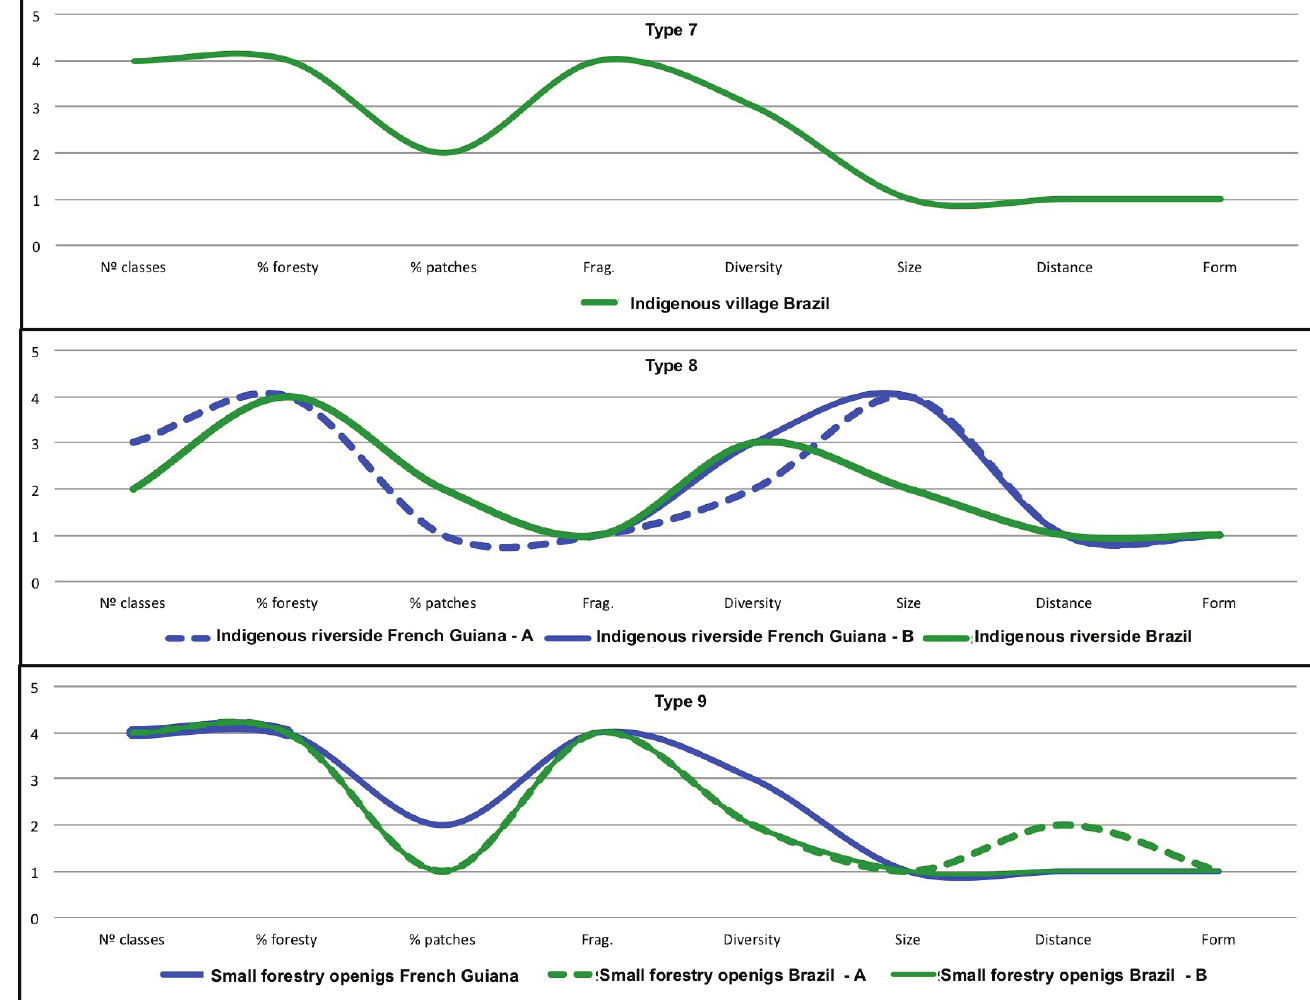
Figure 5. Signatures of the landscape